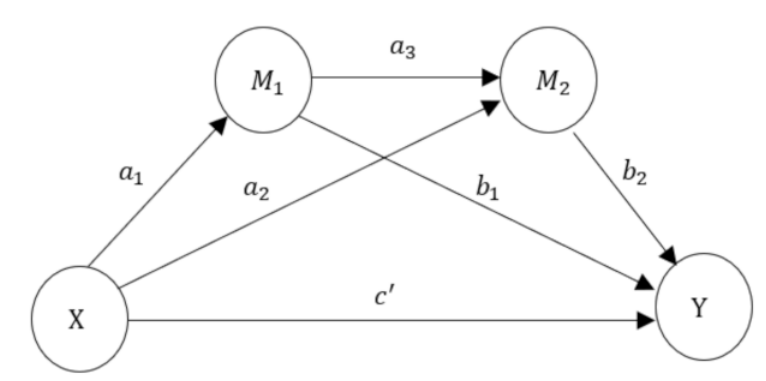
Figure 2. Schematic diagram of multiple mediation models. Table 5. The statistical results of sub-models